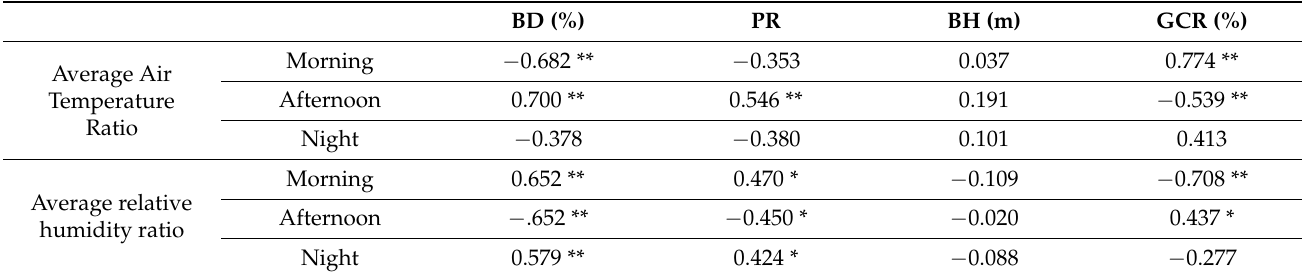
Table 8. Pearson’s correlation coefficients between air temperature ratio (relative humidity ratio) and urban morphology index for the residential district ( n =